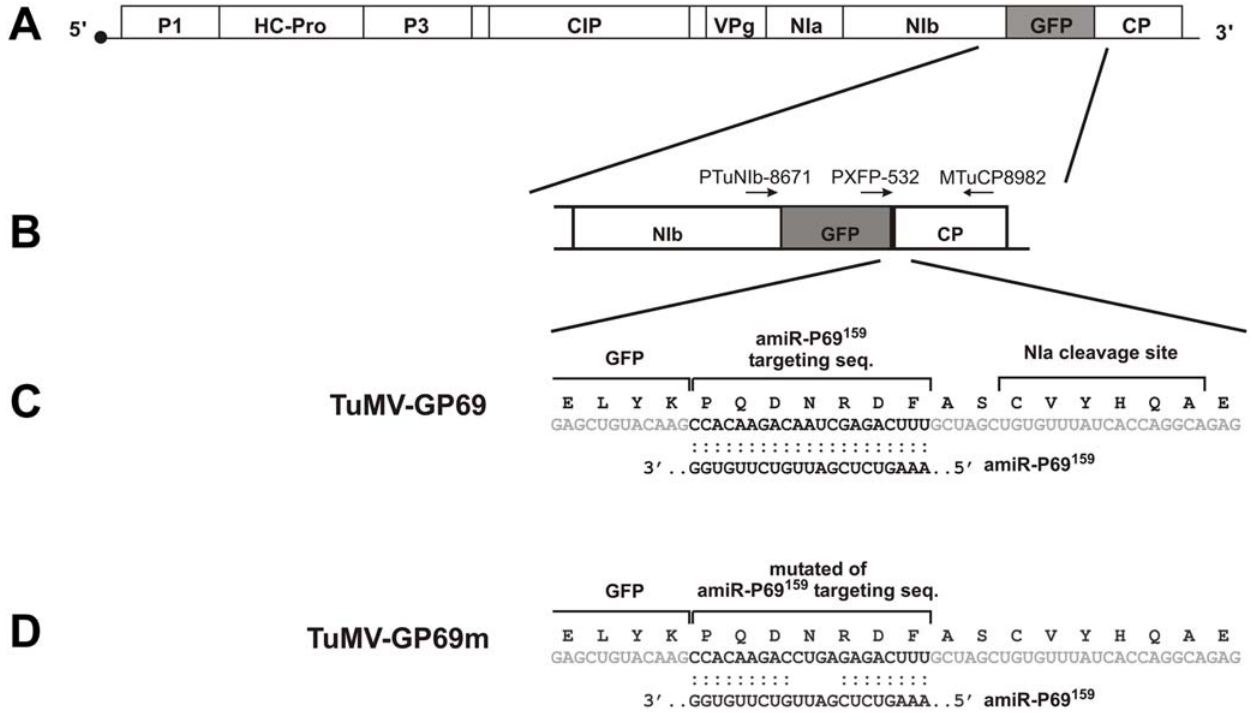
Figure 1. Schematic representations of infectious clones of chimeric Turnipmosaicvirus (TuMV). (A) Schematic representation of TuMV- GFP infectious clone carrying a GFP gene inserted between the NIb and CP genes. (B) Arrows represent the positions and orientations of primers used for RT-PCR. The primer sets PTuNIb-8671/MTuCP-8982 and PXFP-532/MTuCP-8982 were used to amplify the NIb-CP and GFP-CP regions, respectively. (C,D) Schematic diagrams showing the 21-nt sequence of P69 and P69m in the chimeric viruses TuMV-GP69 and TuMV-GP69m, respectively. Predicted base pairing of the 21-nt target RNA sequence (top strand) and amiR 159 -P69 (bottom strand) are shown below the amino acid sequence of the TuMV-GFP